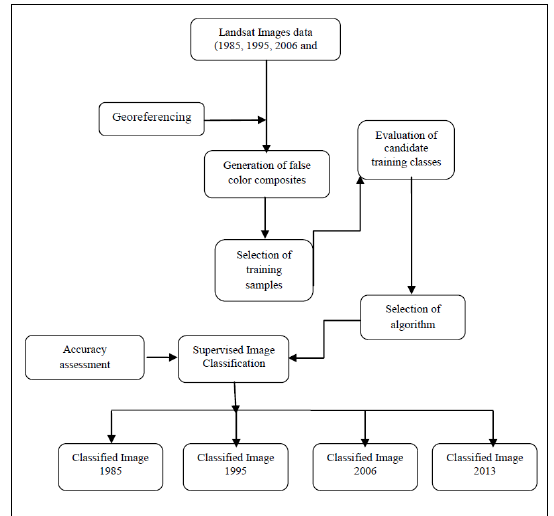
Figure 4. Flowchart of the methodological procedures used to analyzed mangrove